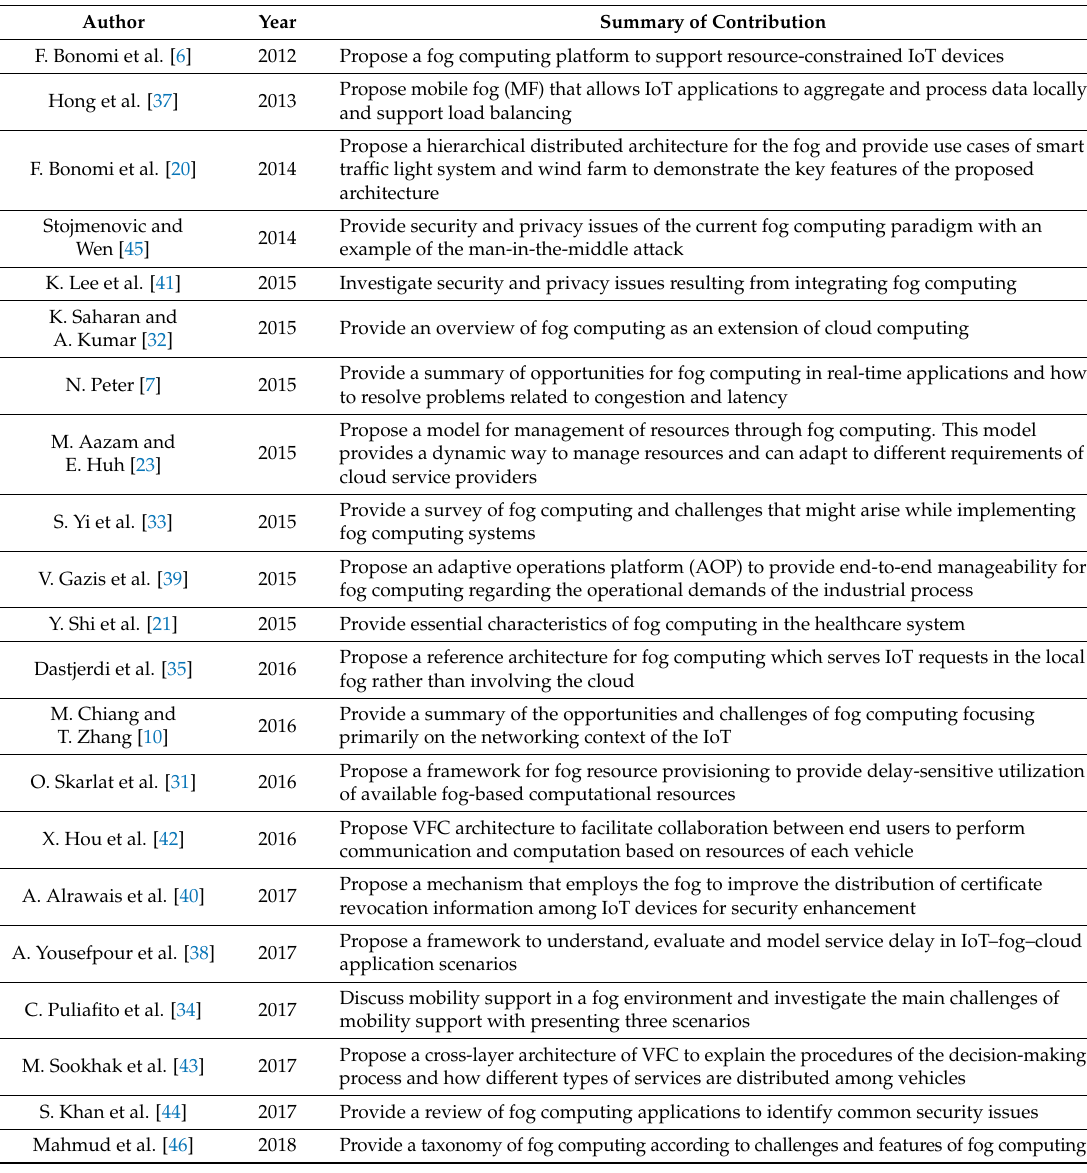
Table 3. A summary of related works that investigated the integration of fog computing with the